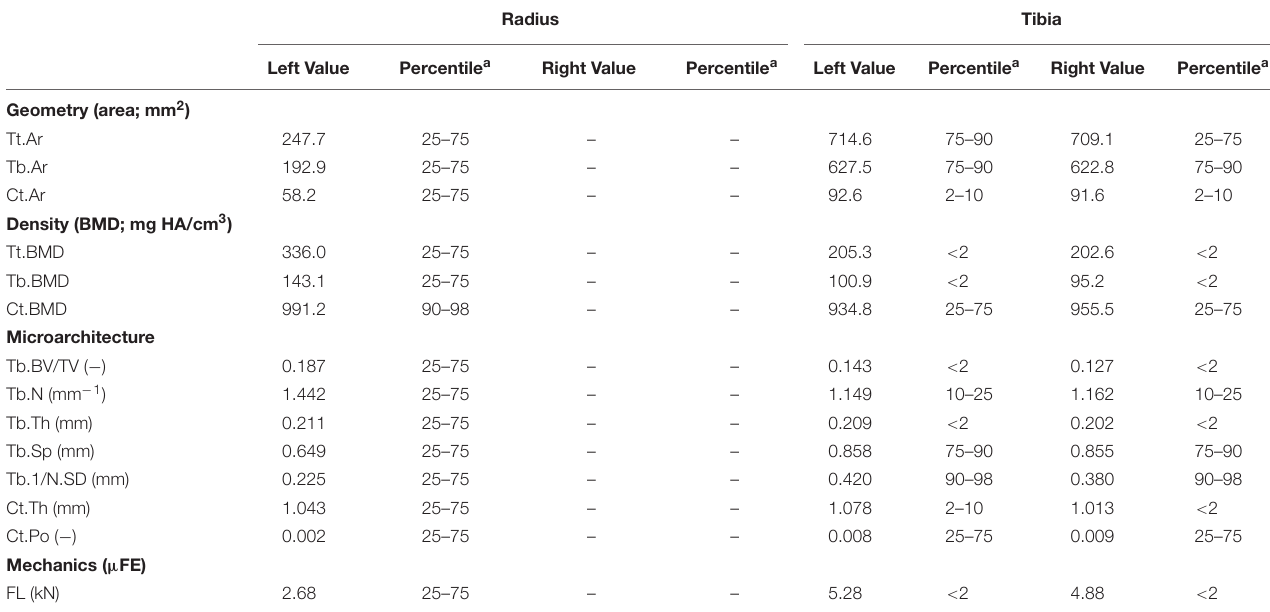
TABLE 1 | Bone parameters of the left distal radius and left and right distal tibia of patient 1, a 33-year-old woman including normative values of the distal radius and tibia of age- and gender-matched controls.